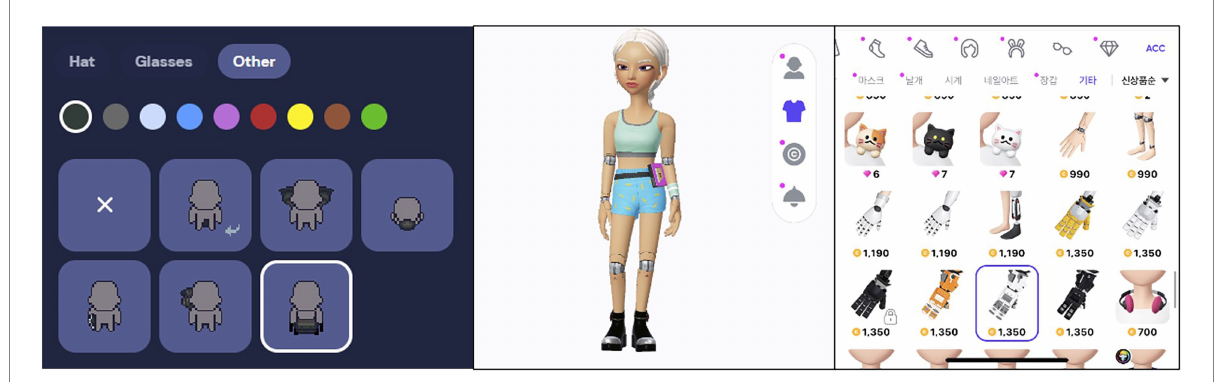
FIGURE 1 Identifiers for physical disability in Gather.town (left) and ZEPETO. Left Image: Reproduced with permission from Gather Presence, Inc., available at https://www.gather.town/. Right Image: Reproduced with permission from NAVER Z Corp., available at